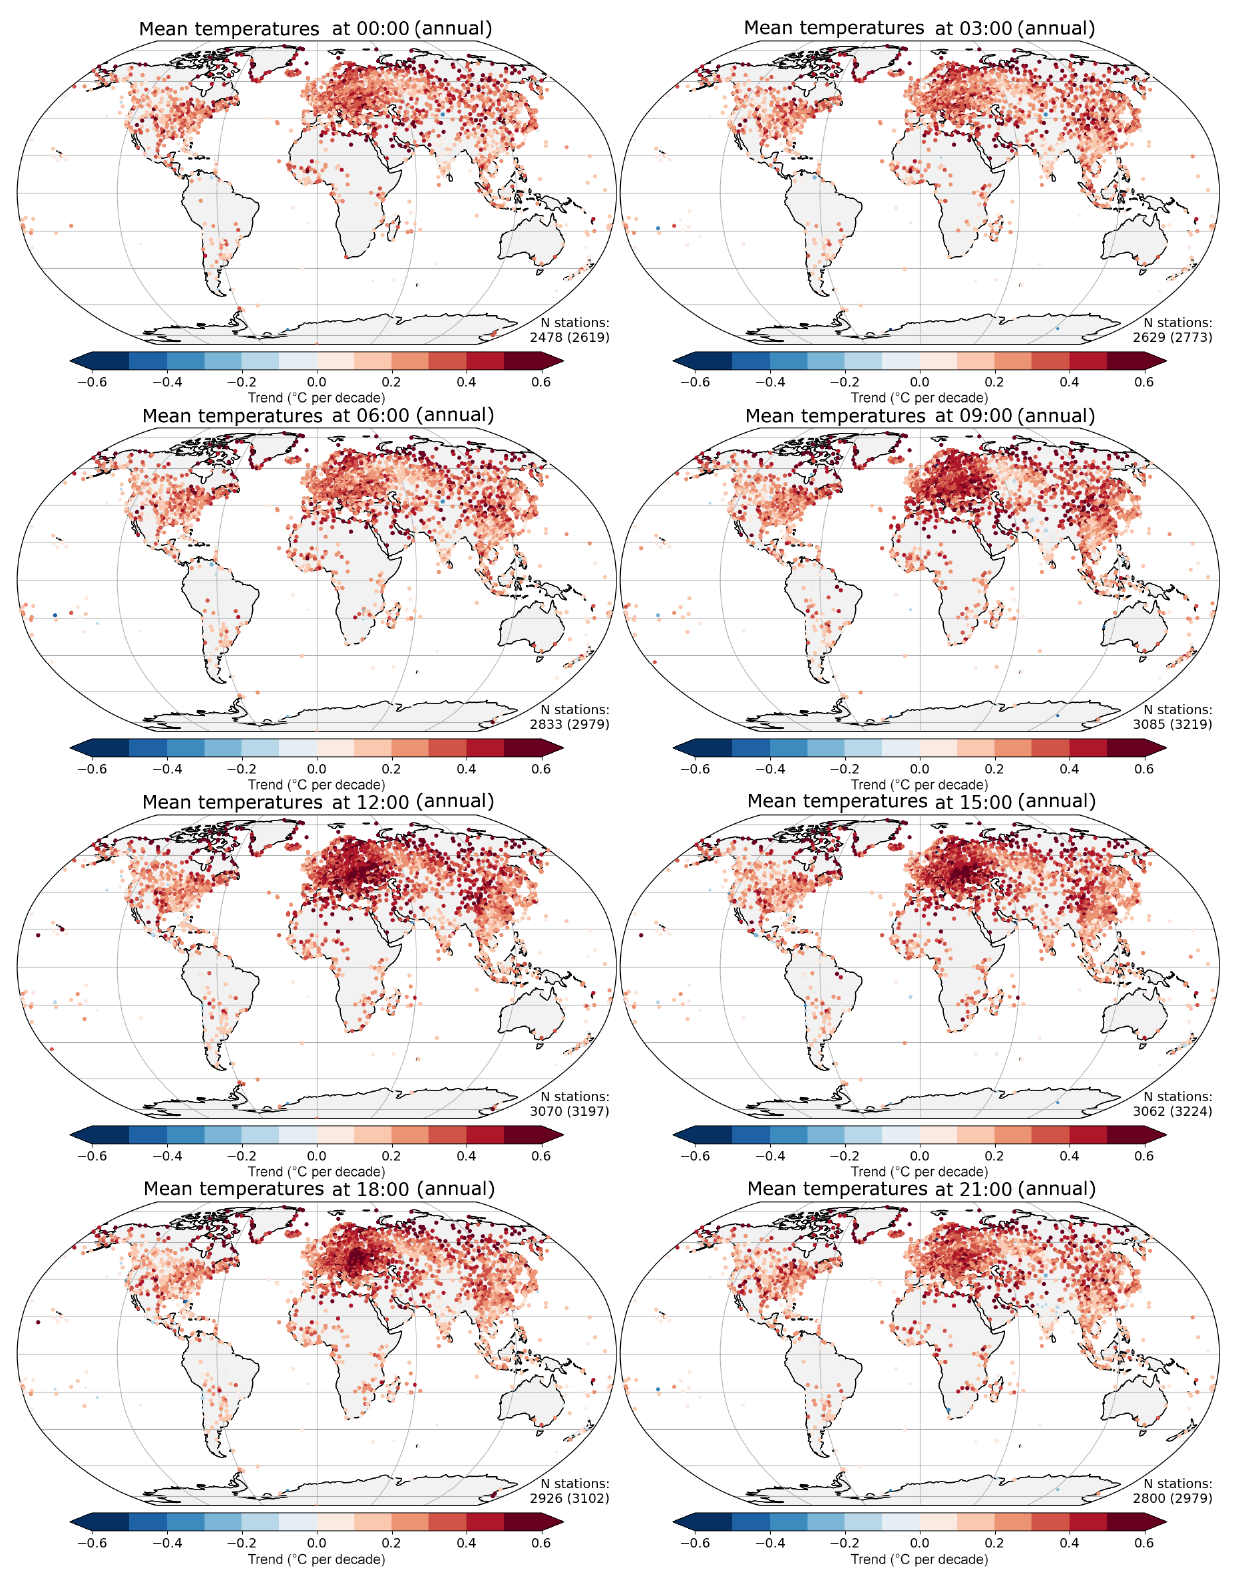
Figure 5. Trend over 1974–2018 in distribution mean for temperature at each 3-hourly interval. The stations where the 1 ˆ σ range of the fitted trend excludes zero are plotted with a larger symbol (the number of these is shown in the bottom right-hand corner of each plot). The total number of stations available is shown in